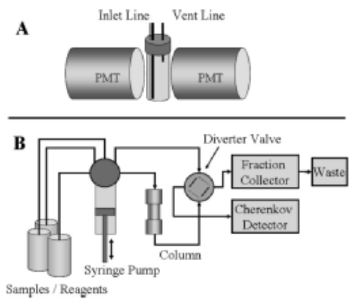
Figure 11. Schematic deposition of a flow-system-coupling Cherenkov detection flow cell configured between dual photo-multiplier tubes (PMTs) [37].